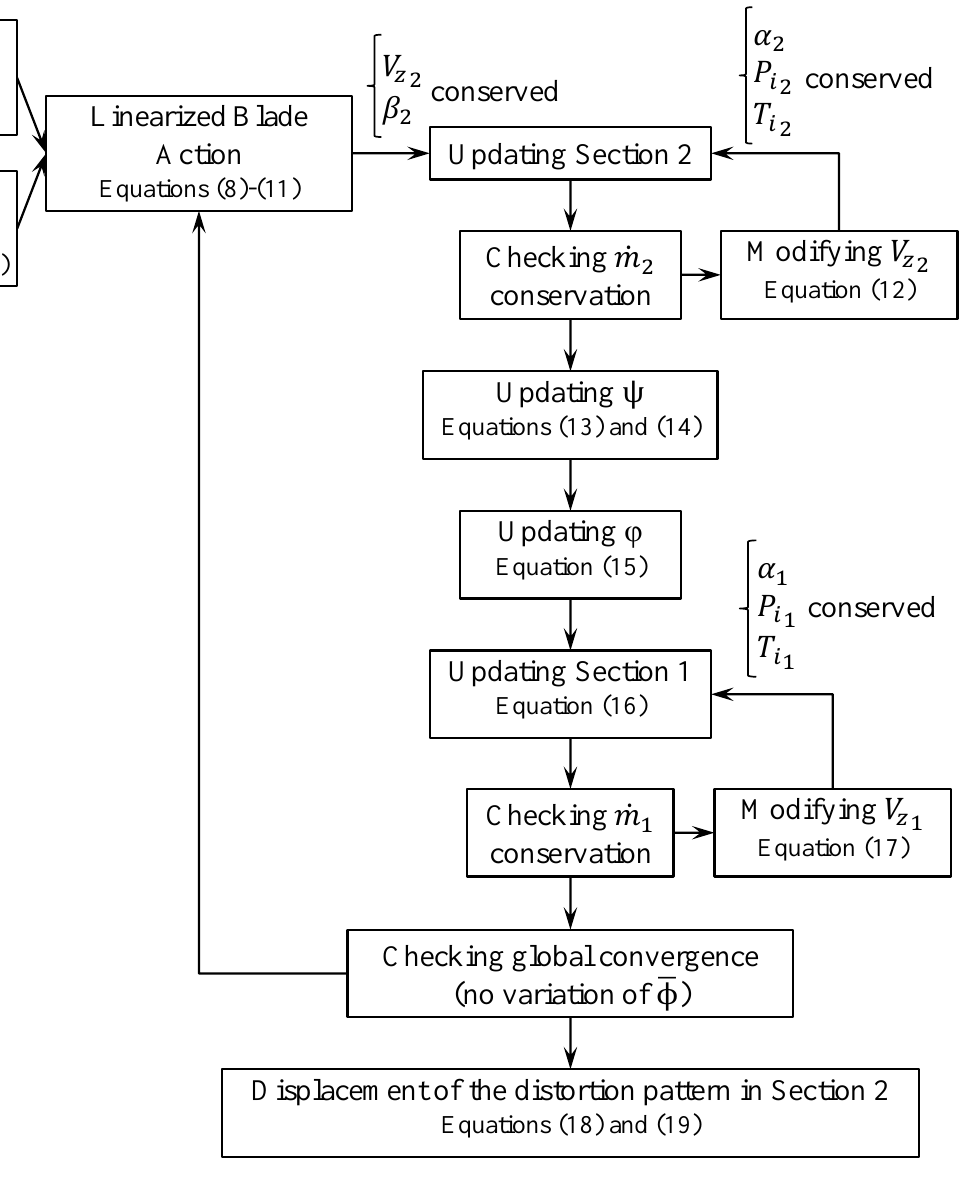
Figure 5. Local parallel compressor